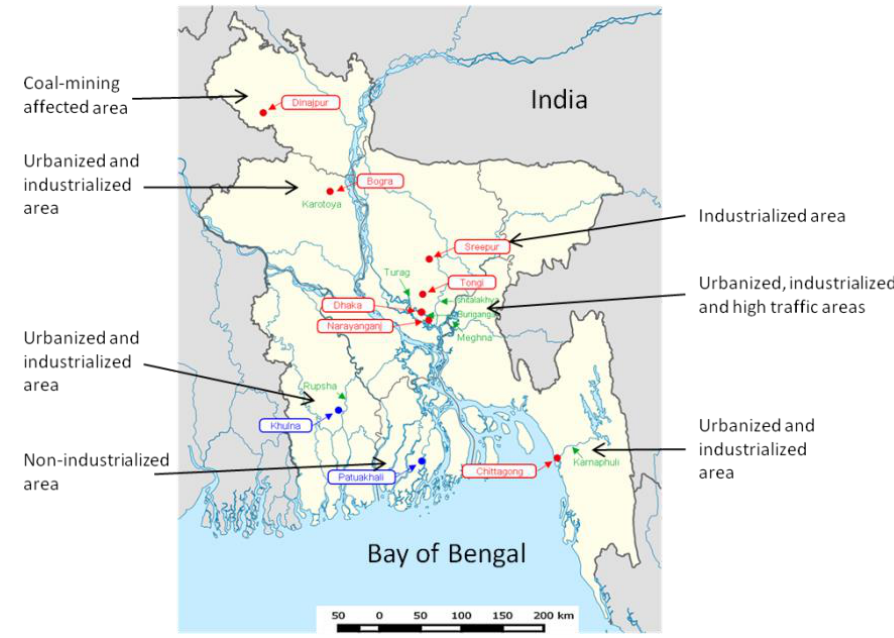
Figure 2. Pb, Cd, and Cr pollution hotspots in Bangladesh. Hot spots of heavy metal pollution were in red. As is not considered here.